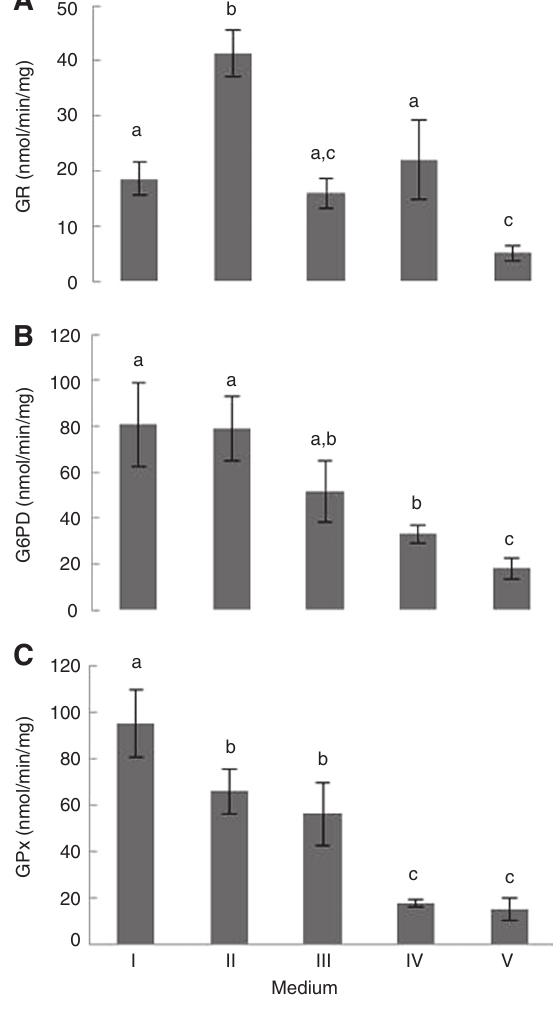
Figure 2: (A) GR, (B) G6PD, and (C) GPx activity of Saccharomyces cerevisiae UE-ME grown in I- YEPG medium, II- YEPGD medium, 3 III- YEPGD medium and 5 μ g/ml TiO -NP add at 100 min, IV-YEPGD 2 medium with heat shock (28/40 ° C) at 100 min,V-YEPGD medium and 5 μ g/ml TiO -NP with heat shock (28/40 ° C) at 100 min. The results 2 represent the mean of five independent experiments ± standard deviation. The bars marked with different letters (a–c) are signifi- cantly different, in accordance with the Duncan test (p <